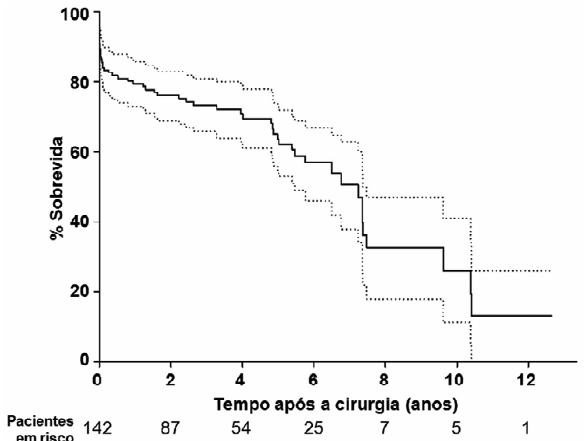
Fig. 2 - Curva de Kaplan-Meier de sobrevida atuarial de 2007 (as curvas pontilhadas representam o intervalo de confiança de 95%)